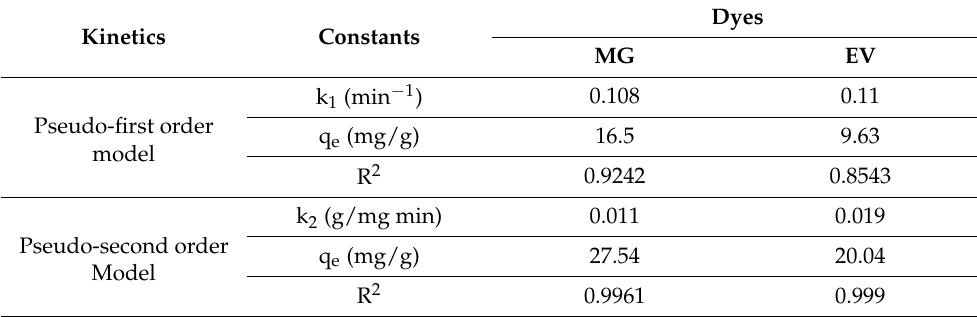
Table 2. Kinetic parameters for the adsorption of MG and EV on to the rGO-ZnS